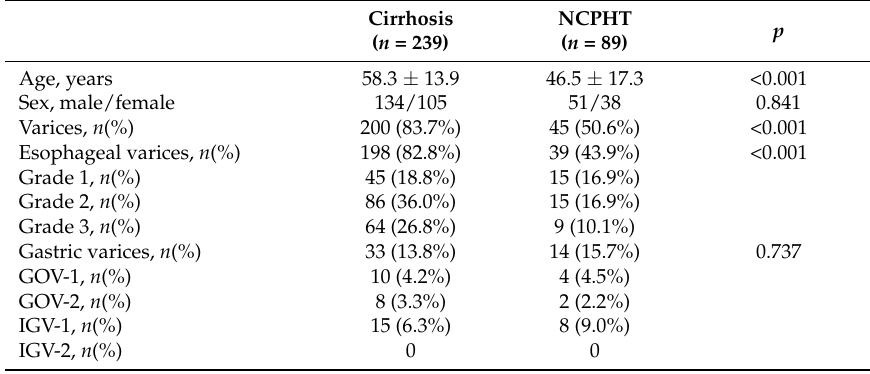
Table 1. Demographic and clinical features of patients with cirrhosis and patients with noncirrhotic portal hypertension